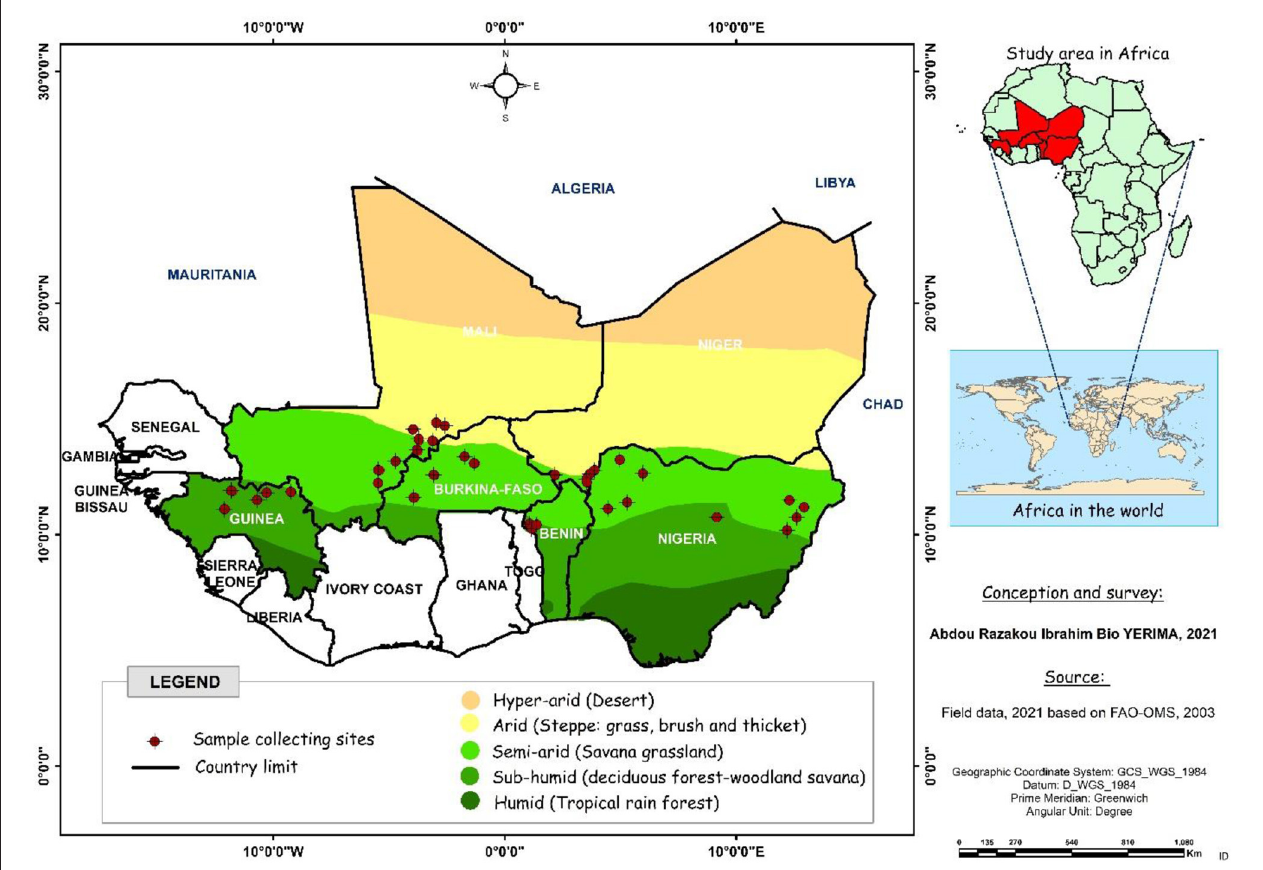
FIGURE 1 | Distribution map of fonio accessions collected from six West African countries (Benin, Burkina Faso, Guinea, Mali, Niger and Nigeria).